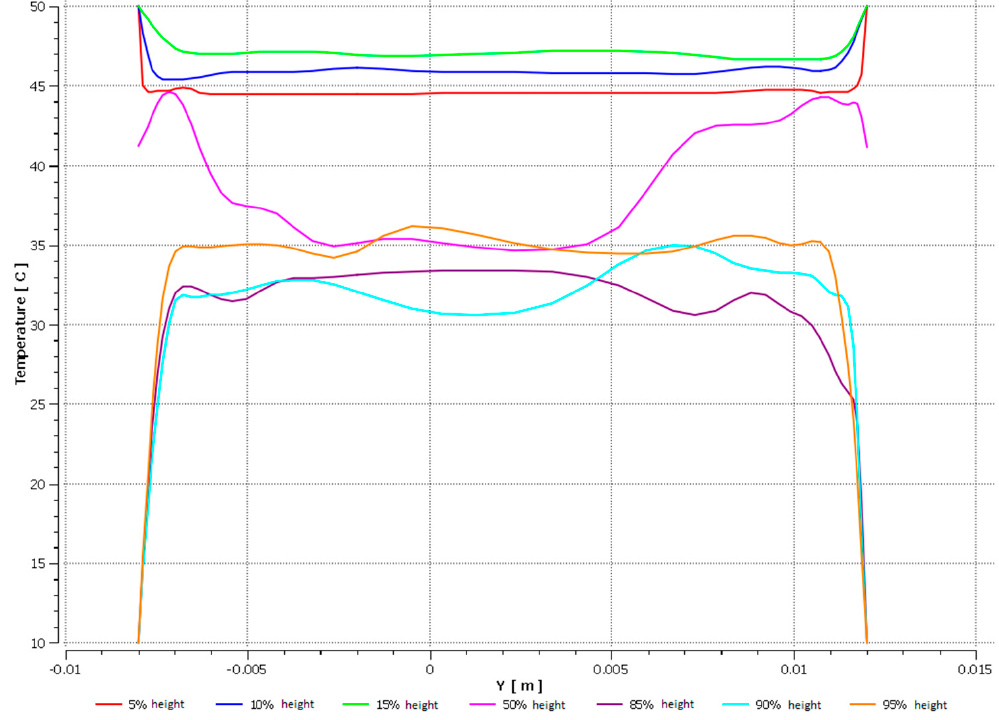
Figure 25. Temperature distribution along the cross-section.